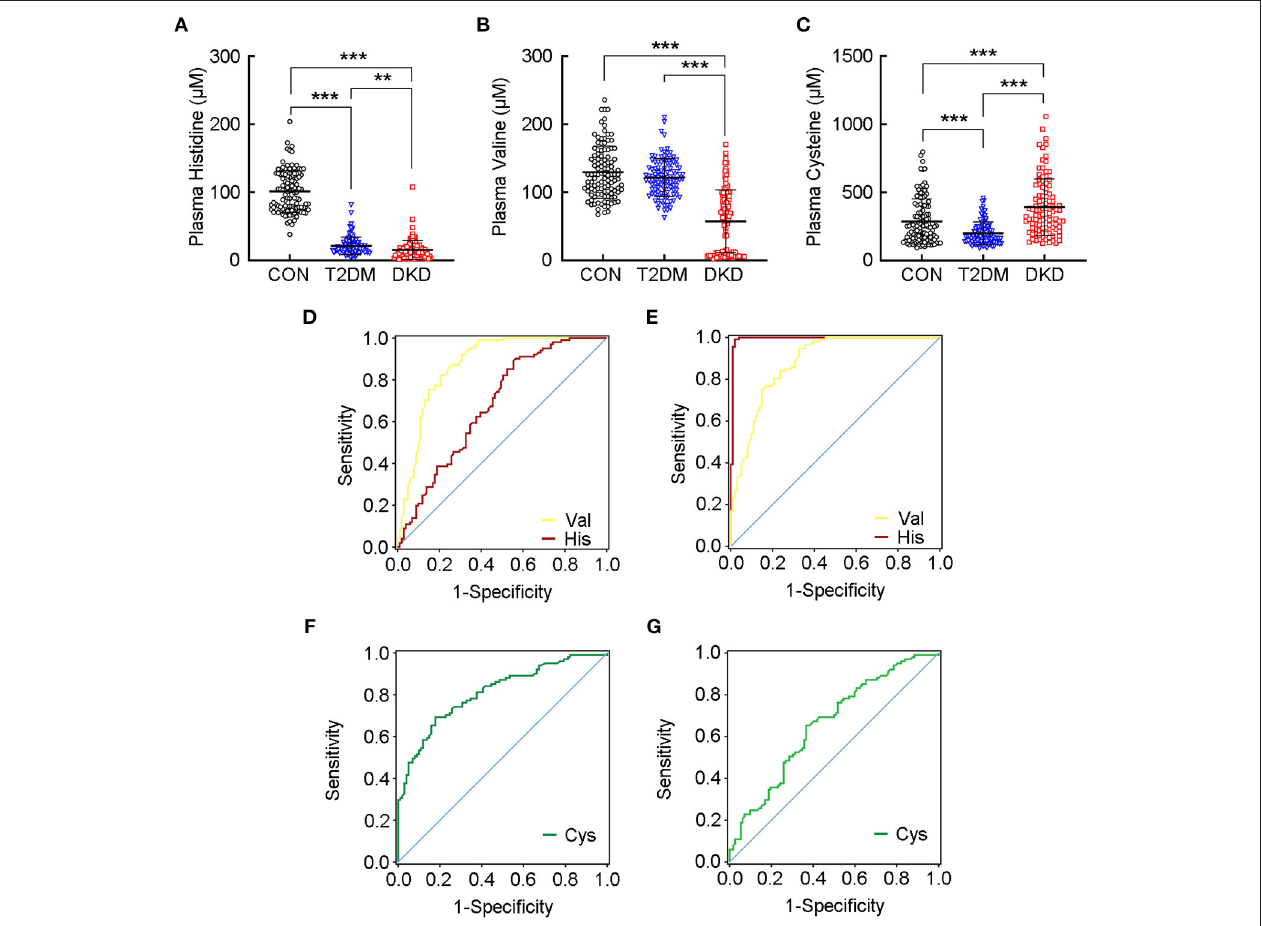
FIGURE 3 | Plasma levels of histidine and valine have an excellent predictive ability to separate patients with DKD from patients with T2DM and healthy controls. Plasma levels of (A) histidine, (B) valine, and (C) cysteine, in the CON group, T2DM group, and DKD group, respectively. Receiver-operating characteristic (ROC) curve demonstrates that the plasma level of valine can discriminate patients with DKD from patients with T2DM (D) , and from healthy controls (E) according to area under the ROC curve (AUC) values greater than 0.85, whereas the plasma level of histidine has excellent predictive ability to discriminate patients with DKD from healthy controls (E) . ROC curve shows much lower AUC values for cysteine in both patients with DKD vs. patients with T2DM (F) , and patients with DKD vs. healthy controls (G) . Detailed AUC values are presented in Supplementary Table 6 . ** P < 0.01, *** P < 0.001. CON, healthy control; DKD, diabetic kidney disease; T2DM, type 2 diabetes mellitus.